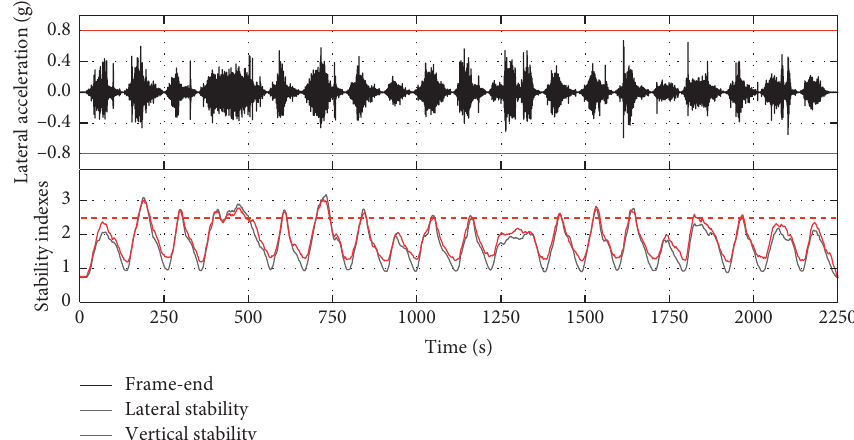
Figure 4: Stability indexes and lateral acceleration at frame-end.